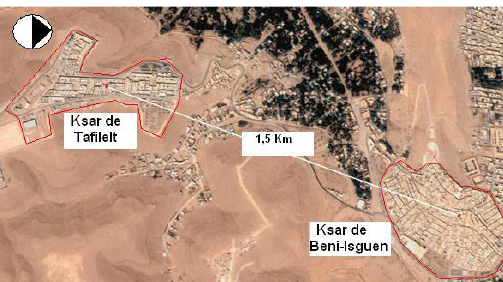
Figure 2: Situation of the two ksour with the distance between them. (Chabi, 2008)